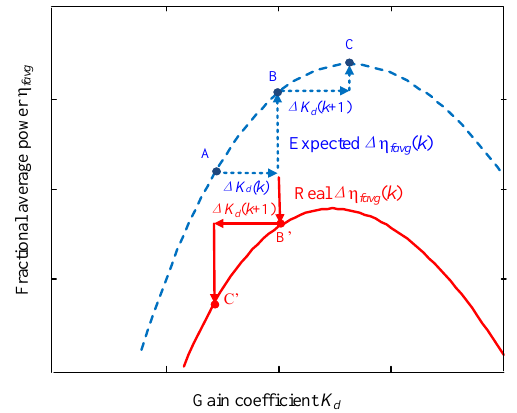
Figure 5. ATG control losing its tractability under changing wind speed and traveling downhill instead of climbing uphill, where the solid and dashed lines are the optimal torque curves under different wind speeds.